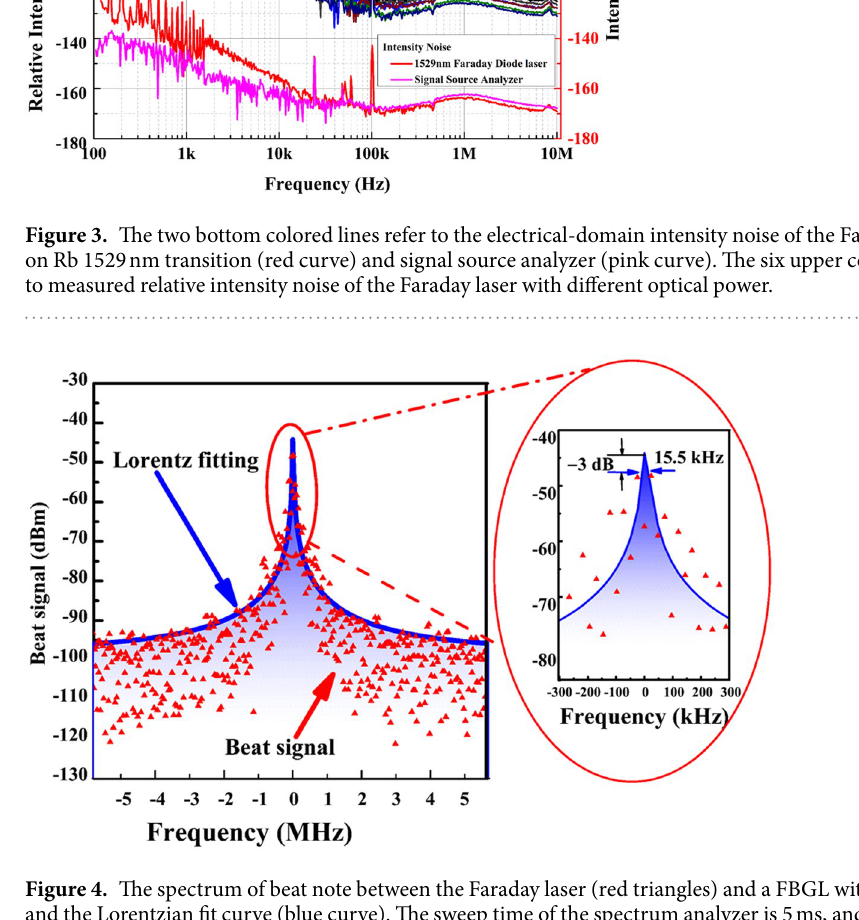
our experiment are shown in Fig. 5(a). Under the condition of the LD temperature ranging from 11 °C to 32 °C and the current from 85 mA to 171 mA, the measured frequency of the Faraday laser centers on 196022.875 GHz corresponding to one of twin-peak line-shaped transmission spectrum with maximum transmittance of 46%. In the upper subfigure, the blue curve presents the frequency of the Faraday laser as a function of the LD tempera- ture ranging from 11 °C to 27 °C with fixed LD current of 127.5 mA. In the right subfigure, the red curve shows the frequency of the Faraday laser as a function of the LD current ranging from 110 mA to 171 mA with fixed LD temperature of 21.5 °C, the maximum current is limited by LD power supply. As shown in Fig. 2(b) and (c), when the Rb cell temperature is 135 °C, the transmission spectrum of the entire LESFADOF with maximum transmittance corresponds to laser frequency of 196022.875 GHz. That’s the reason why the laser frequency centers on 196022.875 GHz. The frequency fluctuation range of below 600 MHz primar- ily reasults from the mode instability of the optical cavity due to mechanical vibration and air flow. The Faraday laser we demonstrated has an optical cavity length of 60 cm, which provides optical feedback and has wide free spectrum range of 250 MHz. On the basis of previous studies 23, 24 , a longer fiber can be used as an extended cavity to limit the laser frequency to the center of transmission spectrum and reduce laser frequency long-term drift, which can further improve the frequency stability and narrow optical linewidth. Hence a fiber-based Faraday laser lasing on Rb 1529 nm with an ultra-narrow bandwidth can be realized. The measured result of 24-hour long-term frequency fluctuations of the Faraday laser is shown in Fig. 5(b). Under the condition of LD current of 141.5 mA and LD temperature of 21.5 °C, the frequency fluctuation range is about 600 MHz within 24 hours. The Rb cell temperature remains at 135 °C in this measurement.